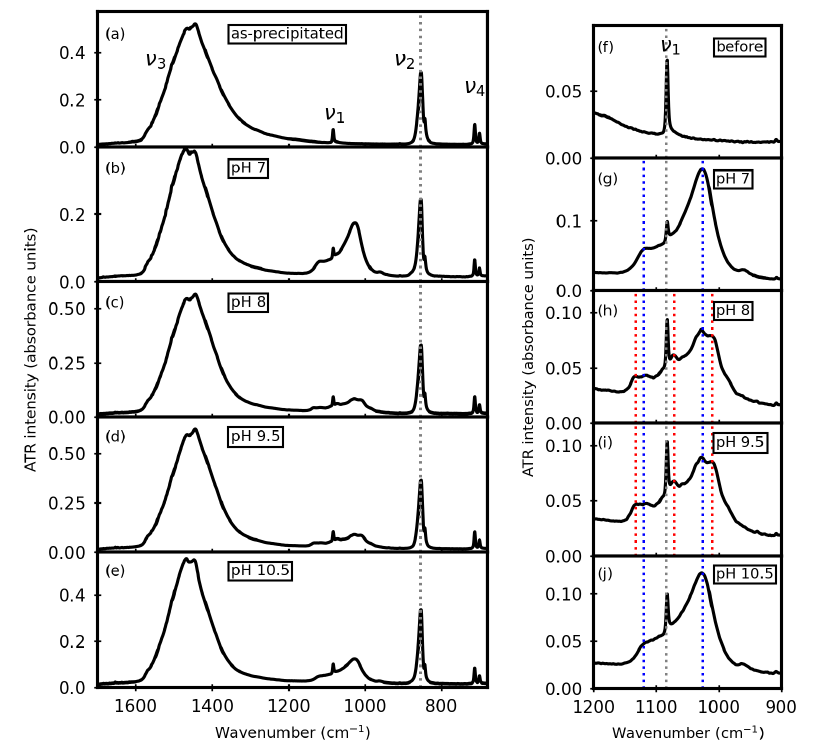
Figure 3. Representative ATR-FTIR data of as-precipitated powders before ( a ) and after orthophos- phate treatments beginning near-neutral (pH 7 in ( b )) and progressing to more alkaline (pH 8 in ( c ), pH 9.5 in ( d ), and pH 10.5 in ( e )). Evidence of secondary phosphate mineral formation (900–1200 cm − 1 ) is emphasized in the zoomed panels ( f – j ). The grey vertical lines with band labels correspond to aragonite peaks, while the blue vertical lines and red vertical lines denote the peak positions of HAp and brushite, respectively.